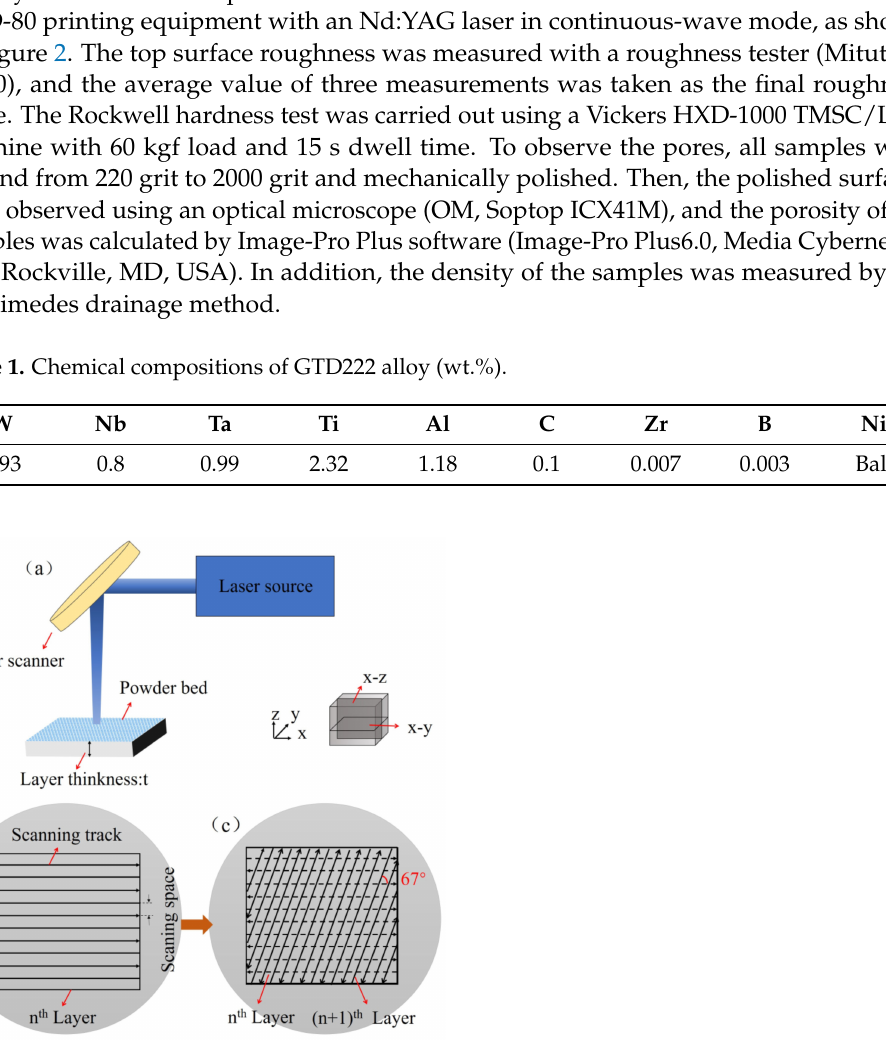
Figure 1. ( a ) Schematic diagram of the LBPBF process for GTD222 alloy, ( b ) laser scanning tracks on